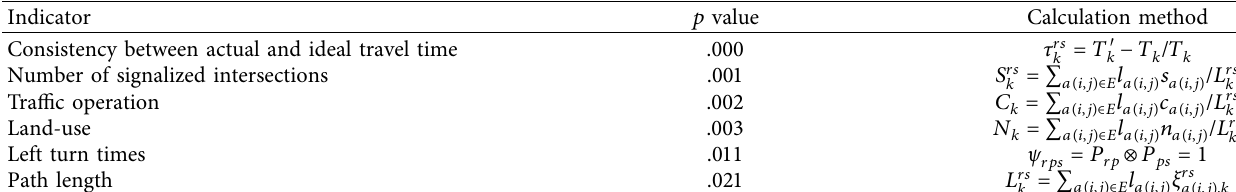
Table 2: Correlation analysis of decision indicator and route selection probability of taxis.